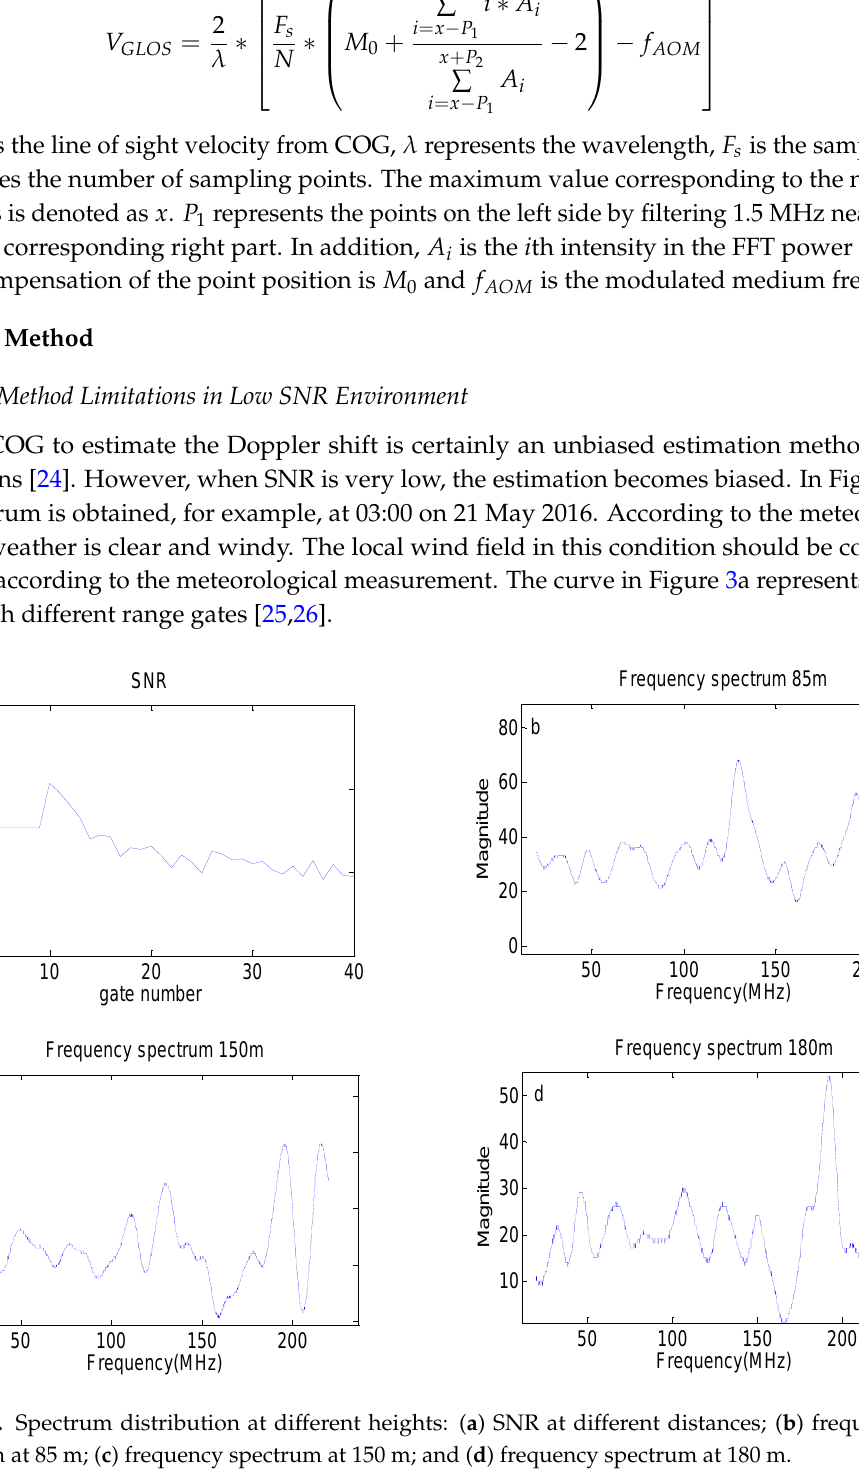
Figure 3. Spectrum distribution at different heights: ( a ) SNR at different distances; ( b ) frequency spectrum at 85 m; ( c ) frequency spectrum at 150 m; and ( d ) frequency spectrum at 180 m.